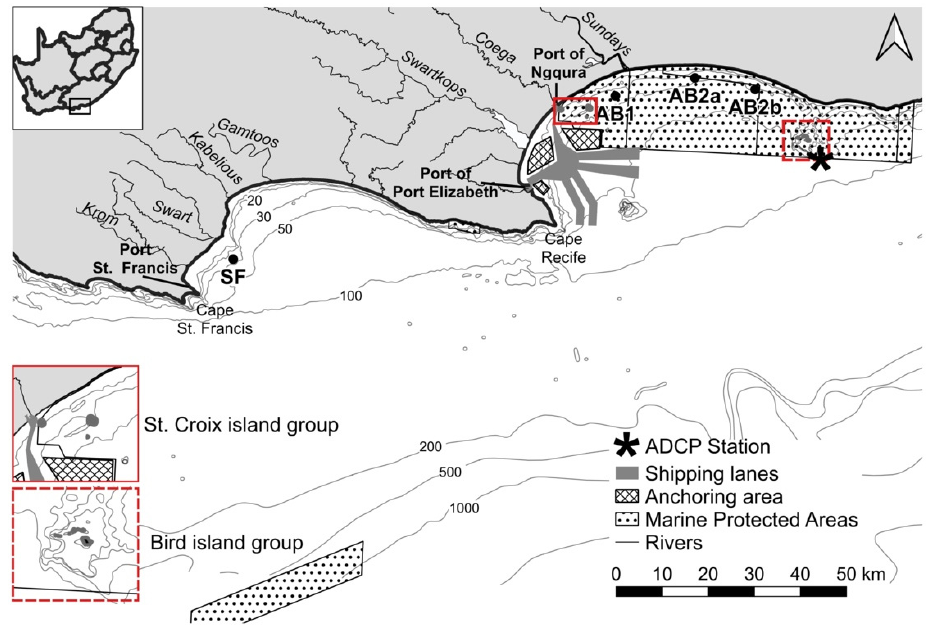
Figure 1. Map of St. Francis Bay (west) and Algoa Bay (east) along the Eastern Cape coast, South Africa. Deployment sites (SF, AB1, AB2a, and AB2b) are shown as large solid dots and the Acoustic Doppler Current Profiler (ADCP) station as an asterisk. Shipping lanes and anchoring areas are depicted in the northwest section of Algoa Bay. Boundaries of Marine Protected Areas (MPAs) are depicted by the dotted